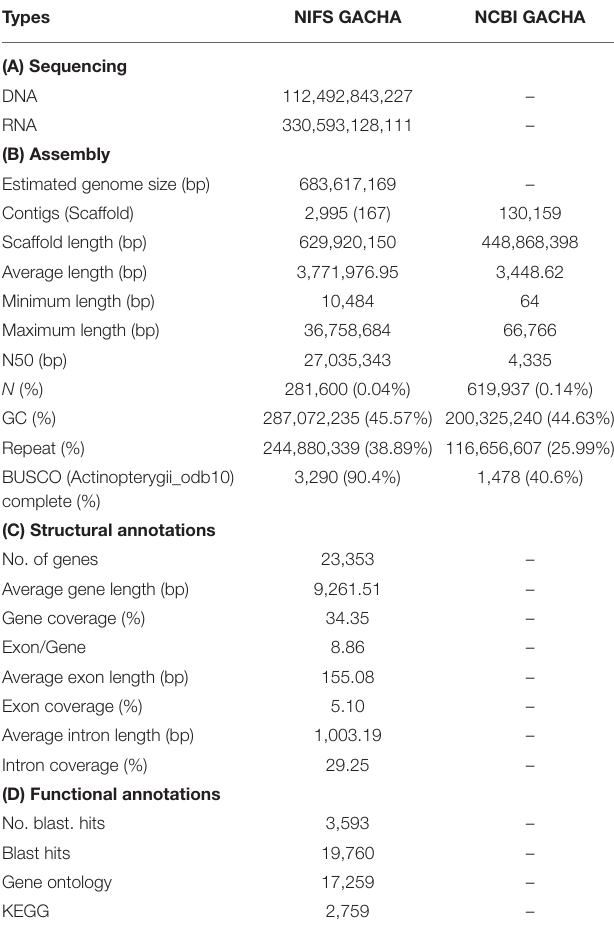
TABLE 1 | Sequencing for annotation of the Gadus chalcogrammus draft